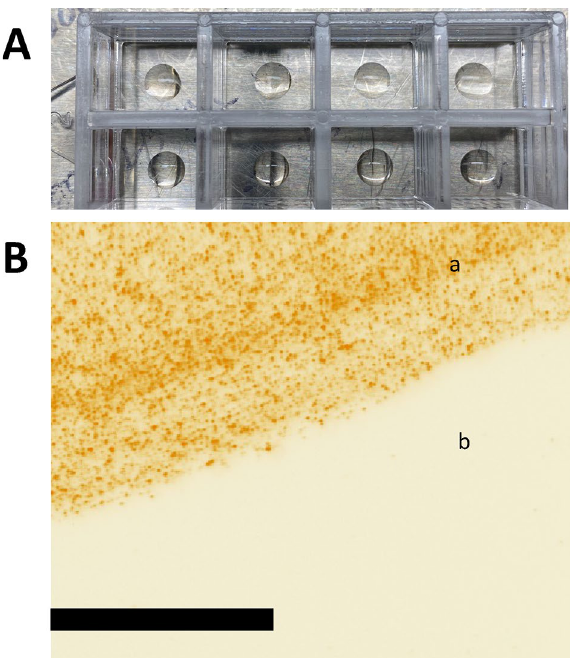
Figure 2. Affinity of UCPV and ACE-2 coated area. ( A ) Typical configuration of the coated area on the Nunc LabTek II 8-well dishes with bottom cover glass. The volume of the ACE-2 coating was (10 µ l). For the rest of the steps in all experiments, the whole well was filled (as described in methods and supplementary materials). ( B ) After polydopamine/ACE-2 coating and blocking, we incubated the plate with UCPV solution (10 µ g/ ml). The image was taken from the edge of the coated area. The area coated with ACE-2 (a in B ) shows a high fluorescence particle count, while the uncoated and BSA blocked area shows no particles at all (b in B ). This shows a relatively very minimal nonspecific binding between the blocked cover glass and